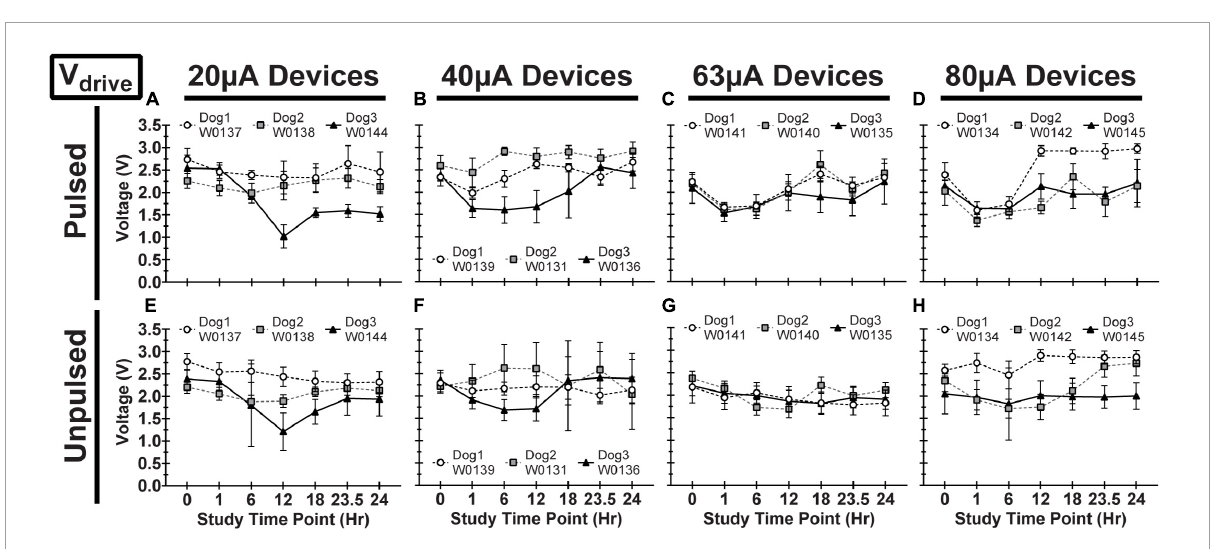
FIGURE9 Driving voltage (V drive ) for pulsed (A–D) and unpulsed (E–H) electrodes in WFMA devices in the four different pulsing groups: 20 µ A (A) and (E) , 40 µ A (B) and (F) , 63 µ A (C) and (G) , and 80 µ A (D) and (H) . Voltage transients (VTs) were recorded at 0hr (before beginning the 24-h pulsing study), at 1h, 6h, 12h, 18h, and 23.5h (during the 24-h pulsing study), and at 24h (after the 24-h pulsing study was complete). All VTs were recorded in response to 40 µ A, 200 µ s pulses. All data shown are mean and standard deviation across all electrodes within the